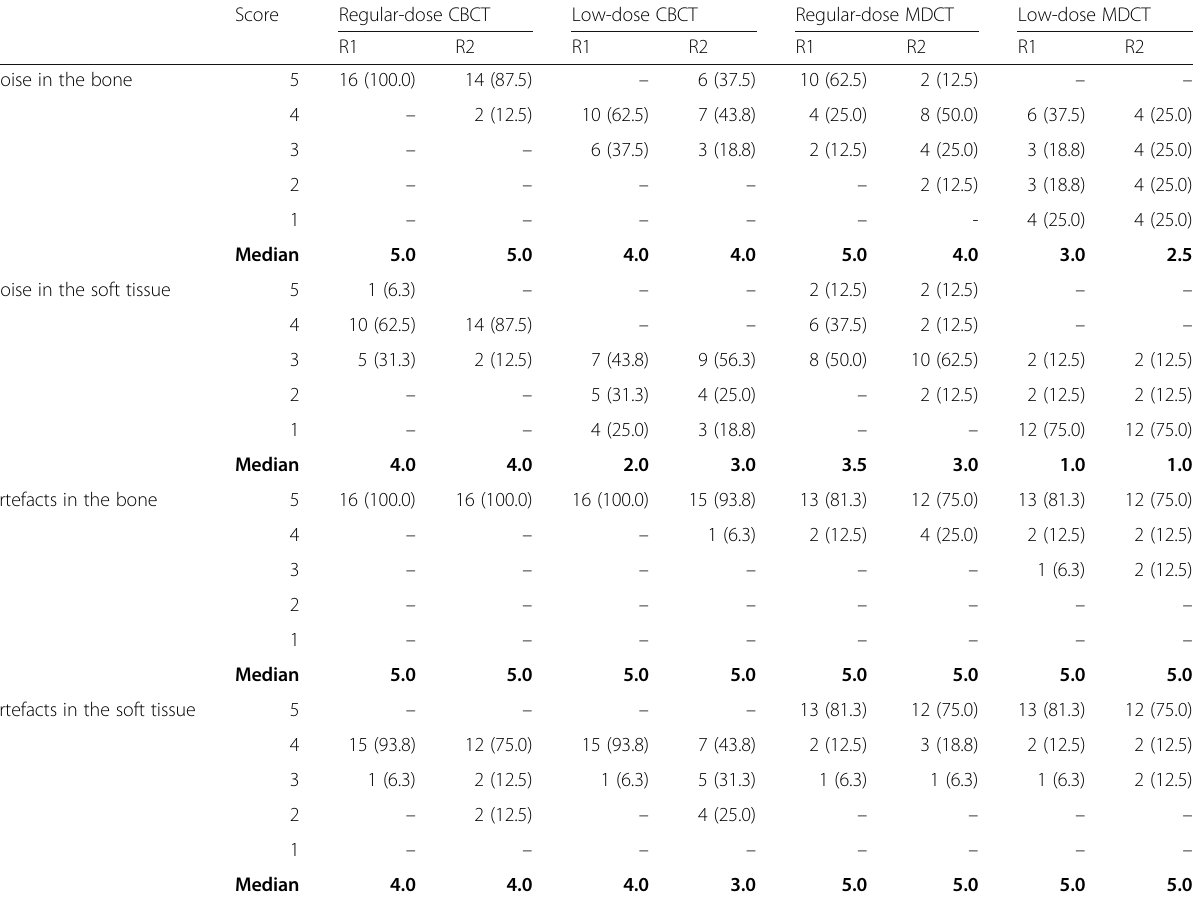
Table 3 Assessment of image noise and artefacts in the bone and soft tissue for cone-beam (CBCT) and multidetector CT (MDCT) by two radiologists (R1, R2) using a five-point Likert